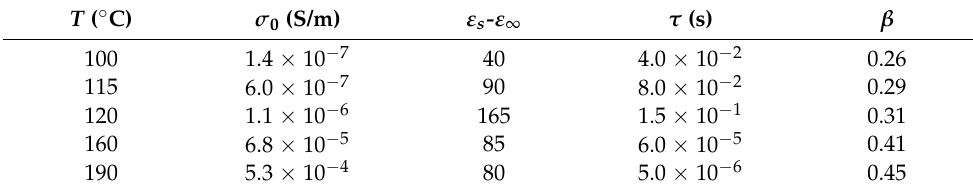
Table 1. List of parameters using the fitting of AC proton